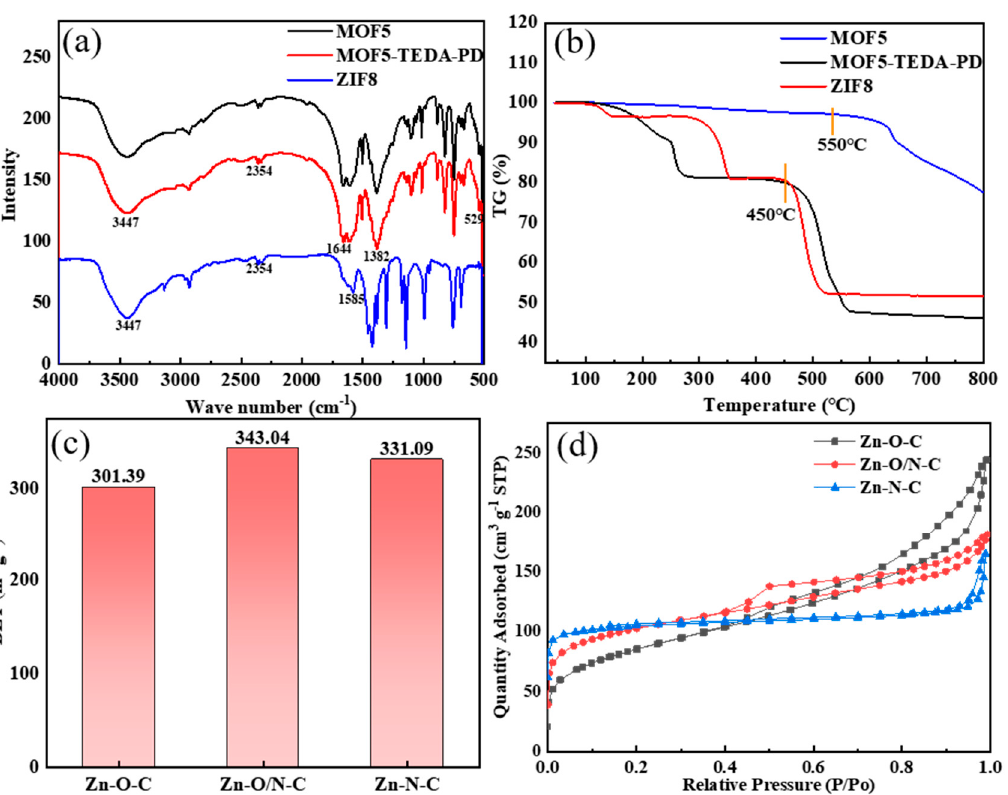
Figure 4. FT-IR spectra ( a ) and TG spectra ( b ) of MOF5, TEDA-PD, and ZIF8. Specific surface areas ( c ) and adsorption and desorption curves ( d ) of MOF5, TEDA-PD, and ZIF8 after calcination.